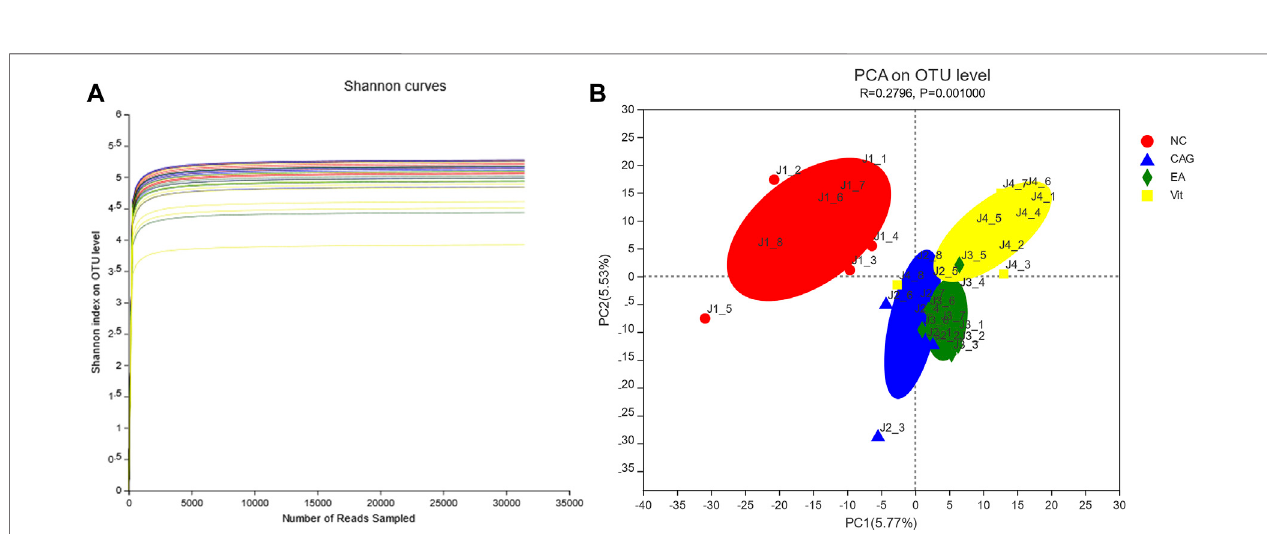
FIGURE 3 | Expression of p53, Bcl-2, and c-myc genes in the gastric mucosa of rats. * p < 0.05 vs . NC, # p < 0.05 vs CAG, and Δ P < 0.05 vs EA. (A) Differences in the expression levels of p53 in rat gastric mucosa. (B) Differences between groups in the expression of Bcl-2 in rat gastric mucosa. (C) Differences in the expression levels of c-myc in rat gastric mucosa. (D) Differences in F/B ratios between groups of rats.